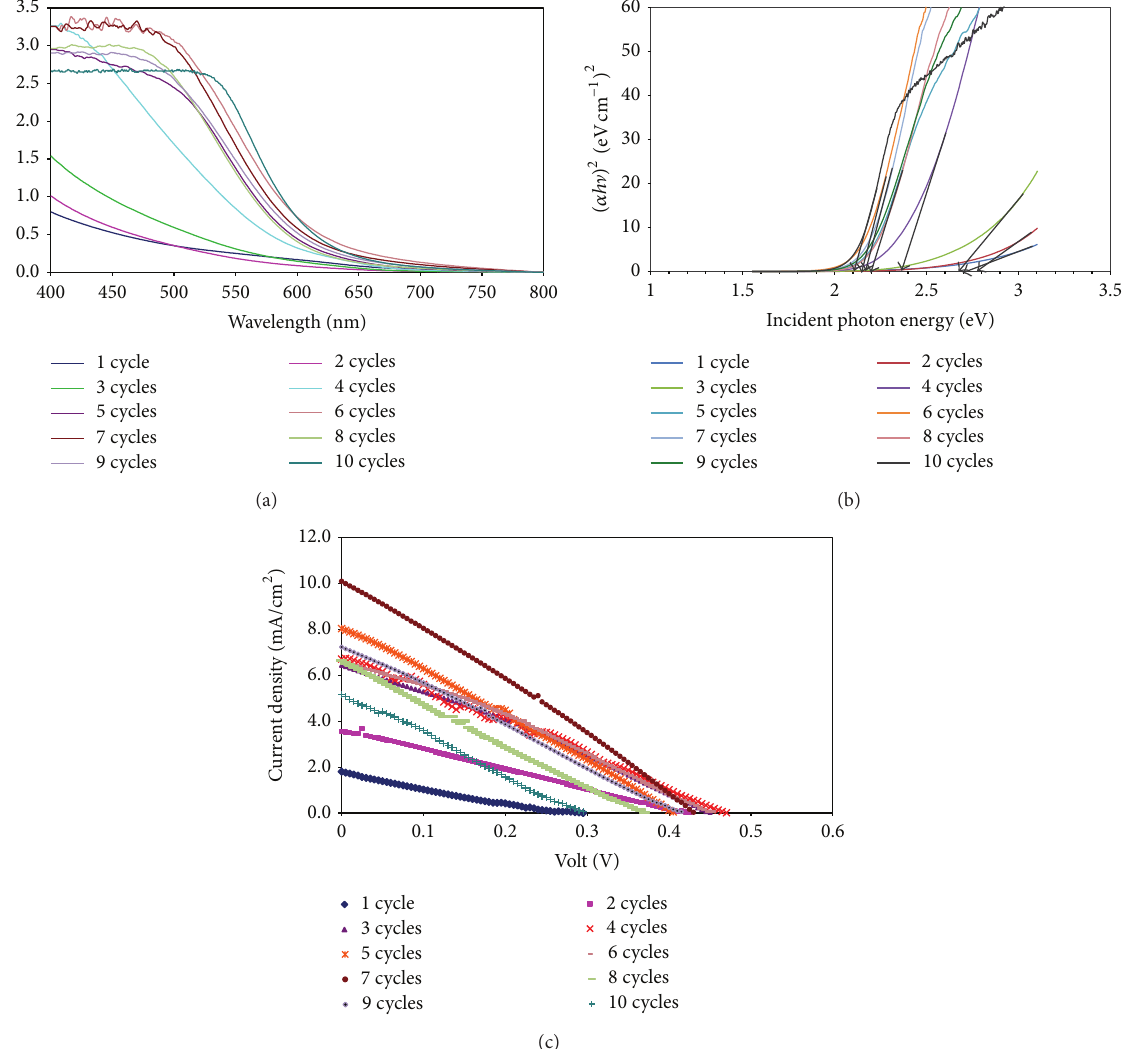
Figure 5: (a) UV-vis spectra, (b) Tauc plot, and (c) J-V curves of QDSSC for CdSe QDs prepared using different number of dipping cycles.